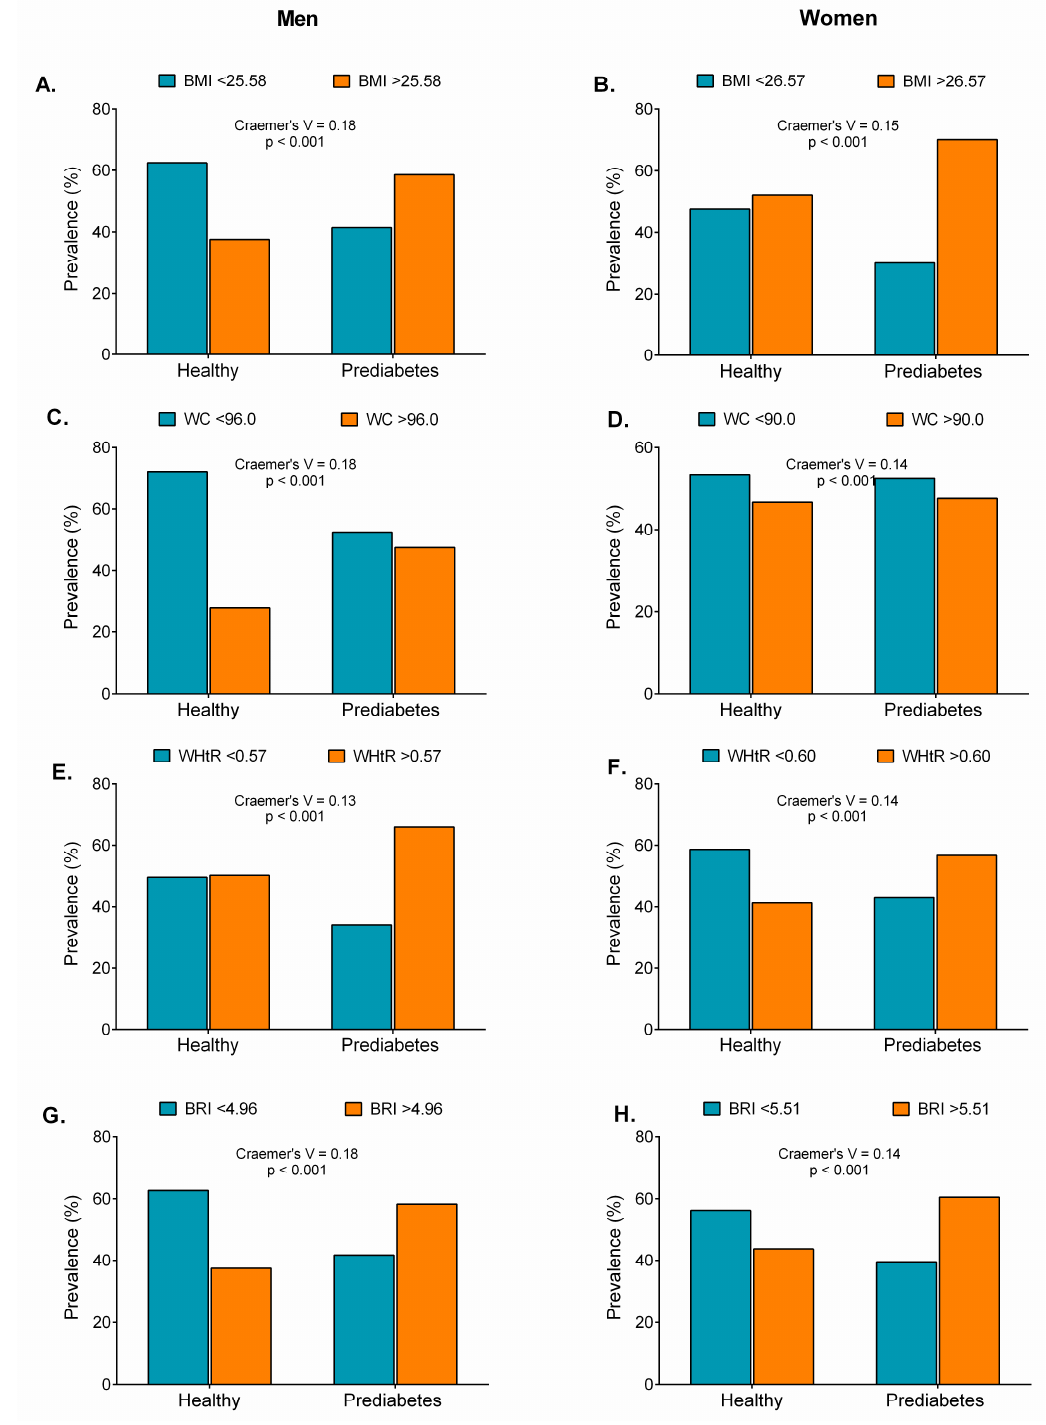
Figure 8. Prevalence of prediabetes according to obesity- and lipid-related index cut-offs (BMI, WC, WHtR, and BRI).